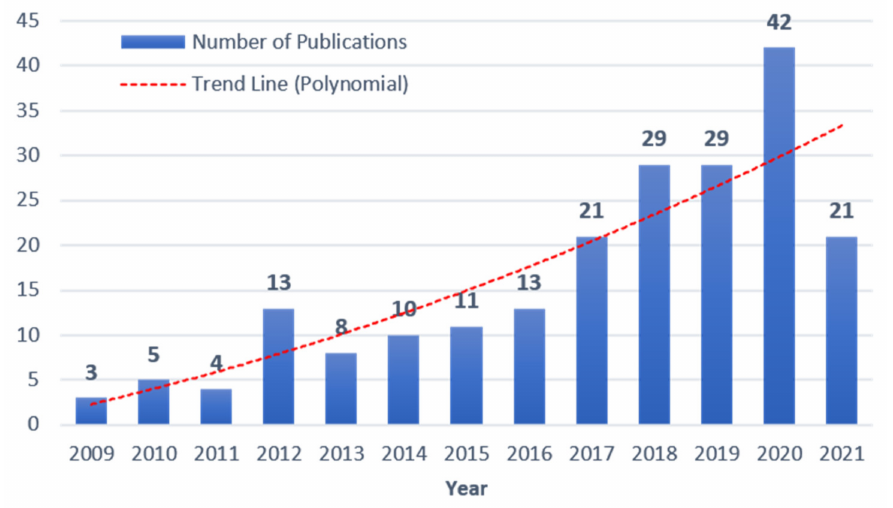
Figure 3. Annual publications from 2009 to 2021 (half-year).